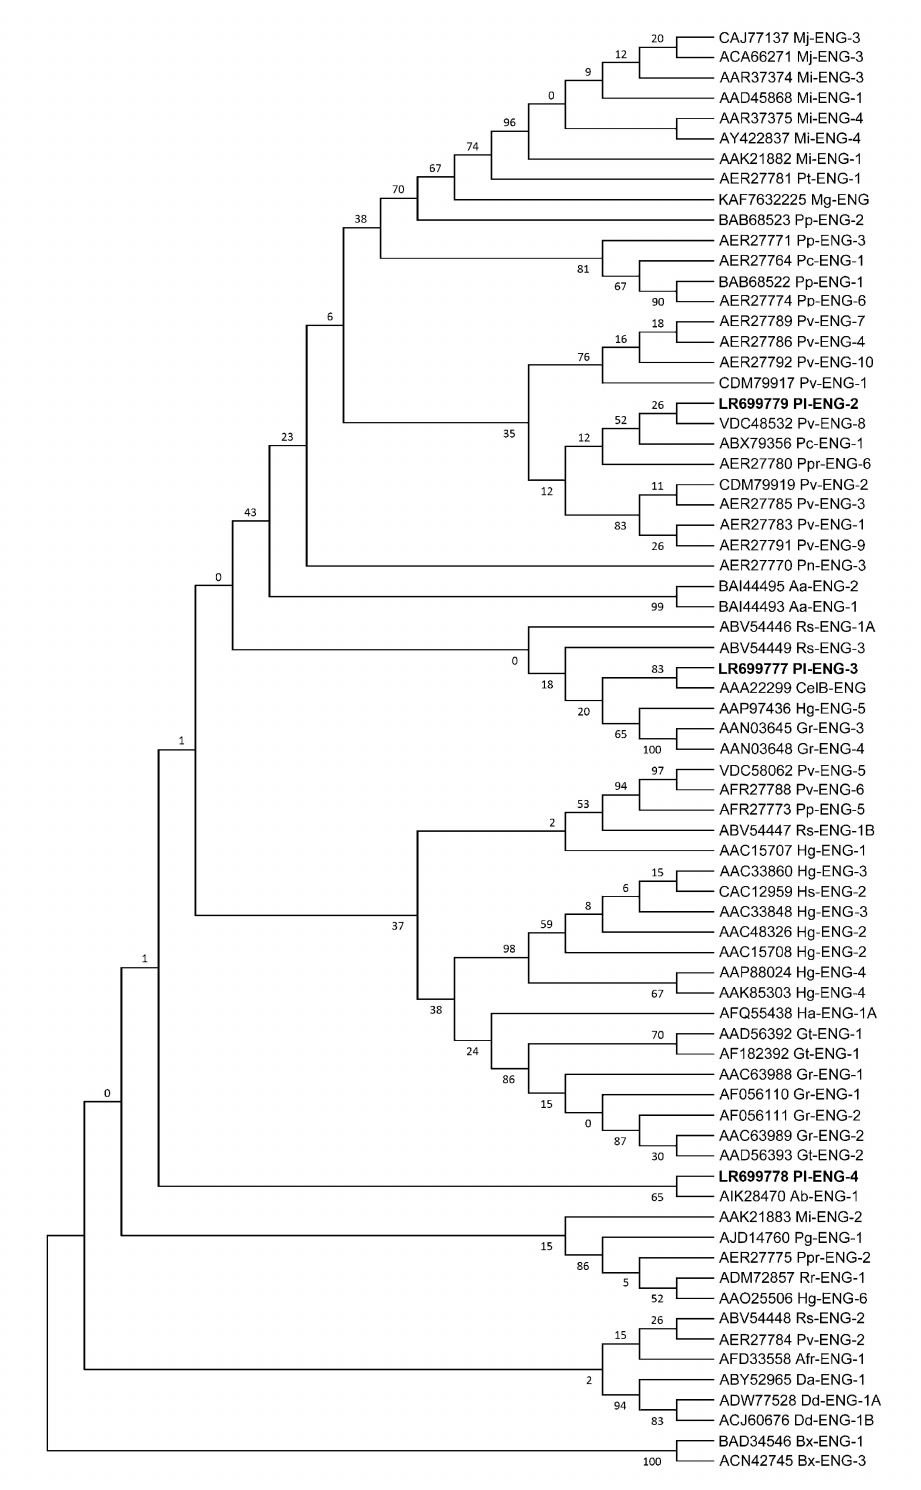
Figure 2. Phylogenetic relationships among the amino acid cellulase catalytic domains of plant parasitic nematodes. The Maximum Likelihood method was used to obtain a bootstrap consensus tree inferred from 1000